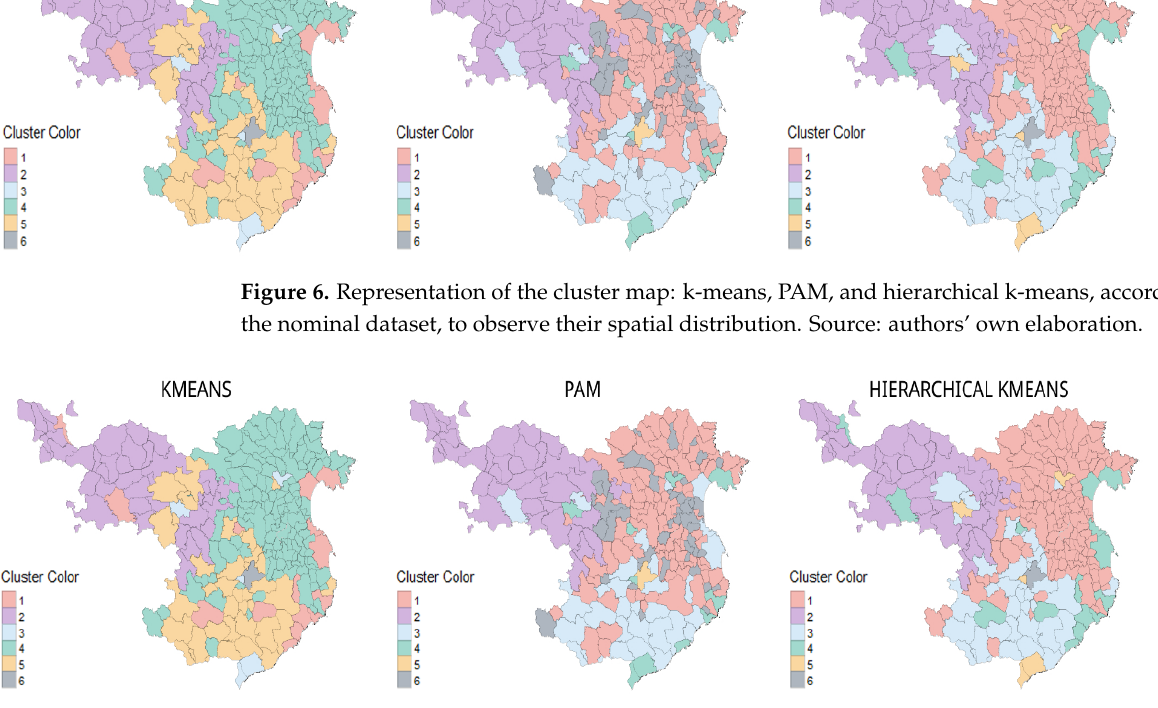
Figure 7. Representation of the cluster map: k-means, PAM, and hierarchical k-means, according to the z-score dataset, to observe their spatial distribution. Source: authors’ own elaboration